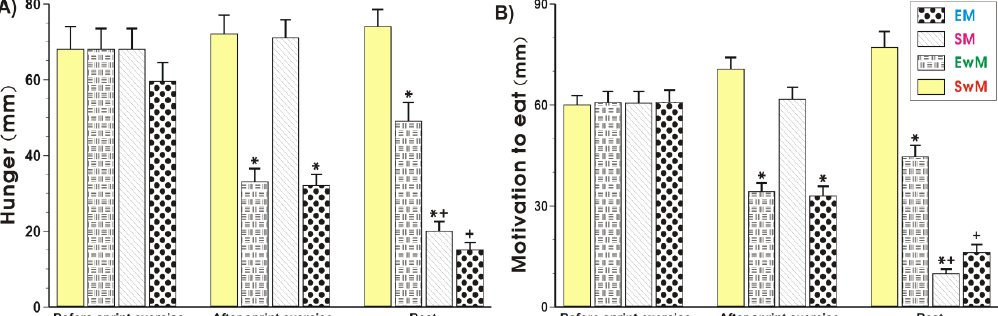
Figure 1. Perceptions of hunger ( A ) and motivation to eat ( B ) in sedentary and exercising human subjects. Values represent means ±SD for 26 subjects. Statistical analysis was done by two-way repeated measures ANOVA and Tukey post hoc test. An asterisk indicates a significant decrease ( p < 0.05) as compared with baseline values at the initiation of the test and with SwM and SM groups before meal consumption. Asterisk and cross indicate a significant decrease ( p < 0.05) as compared with respective values in group SwM and group SM before meal consumption. Cross indicates a significant decrease ( p < 0.05) as compared with respective values in the EM group before meal consumption and the EwM group. EM—the 30 s Wingate Test (W-T30) with ad libitum test meal intake, EwM—W-T30 without ad libitum test meal, SM—sedentary with ad libitum test meal intake, SwM—sedentary without ad libitum test meal intake.